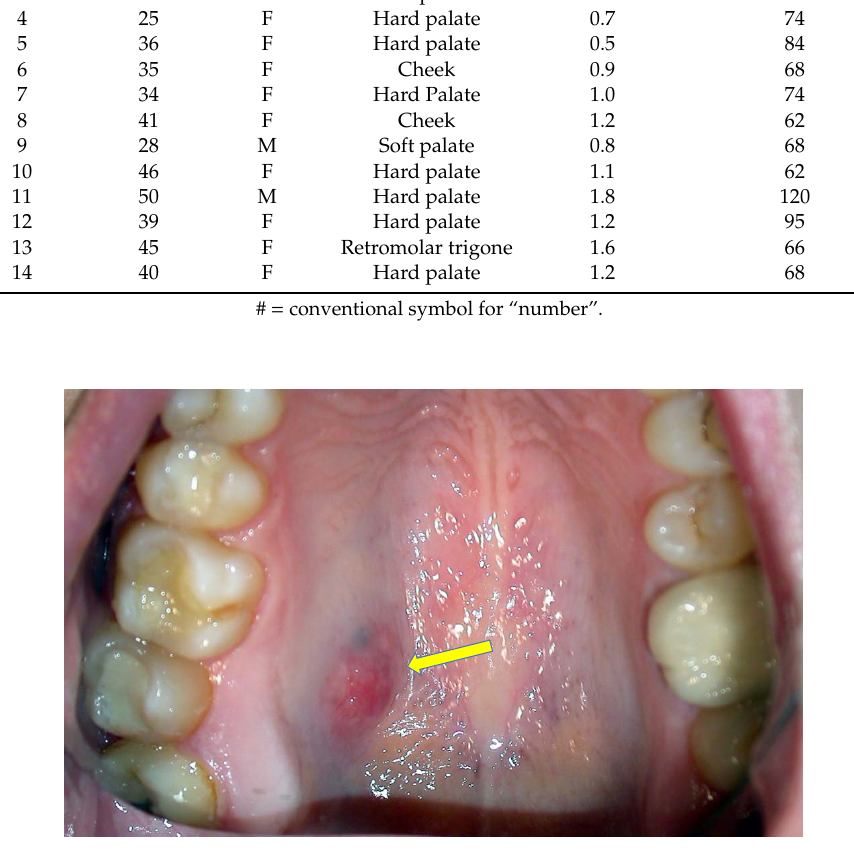
Figure 1. Clinical presentation MEC of the hard palate as a rather well-demarcated nodule with slight erosion of the covering mucosa.